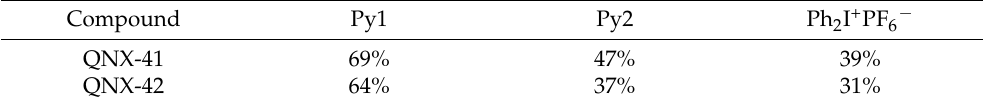
Figure 36. Chemical structures of naphthoquinone-based quinoxalines QNX-41 and QNX-42. Table 13. Monomer conversions obtained during the CP of CHO using Py1, Py2 and Ph 2 I + PF 6 − as the electron acceptors for QNX-41 and QNX-42 after 40 min. of irradiation.